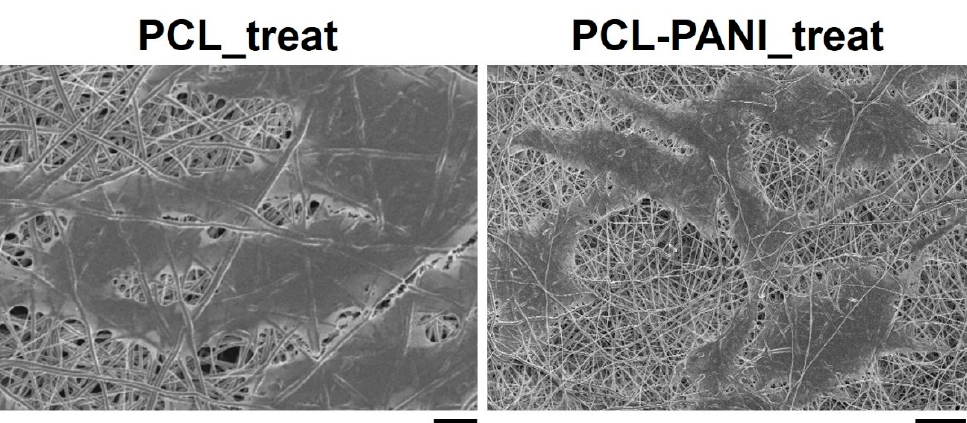
Figure 10. FESEM micrograph of HFF-1 (scale bar = 10 µm, magnification = 1 K×) on PCL_treat and PCL-PANI_treat samples (scale bar = 20 µm, magnification = 1 K×) after 7 days of culture.